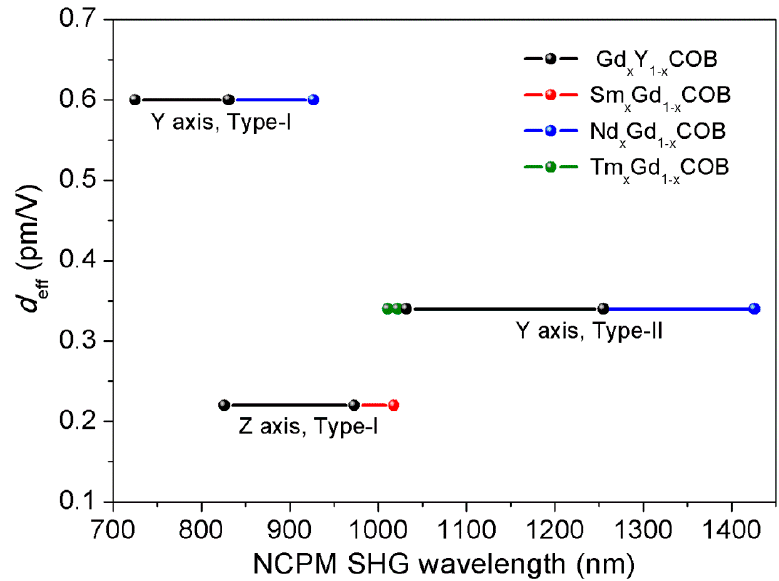
Figure 4. An optimized crystal selecting scheme to completely cover the waveband of 0.72~1.42 µm.